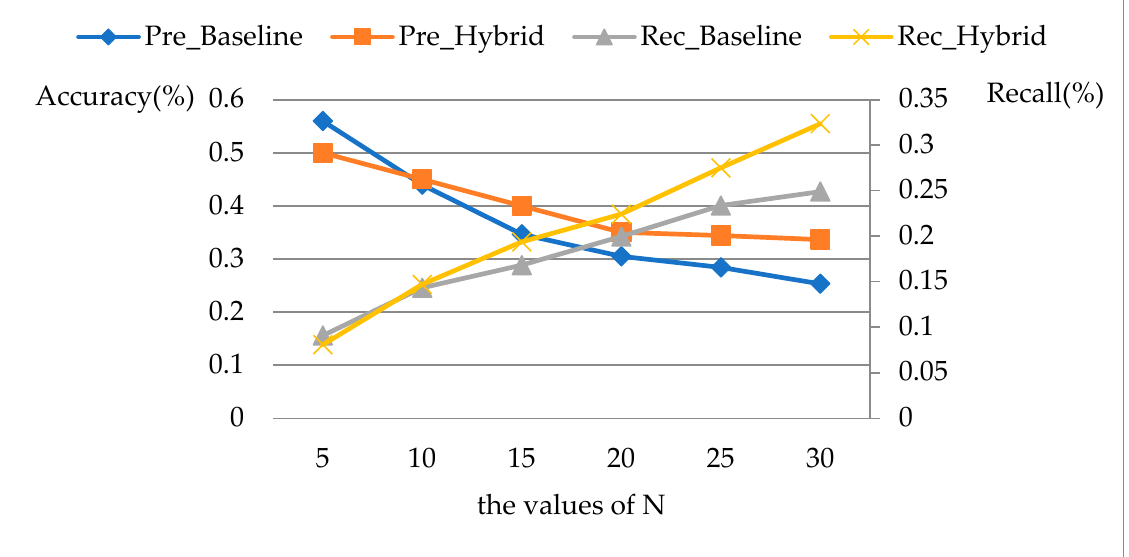
Figure 7. Comparison of Accuracy and Recall results.